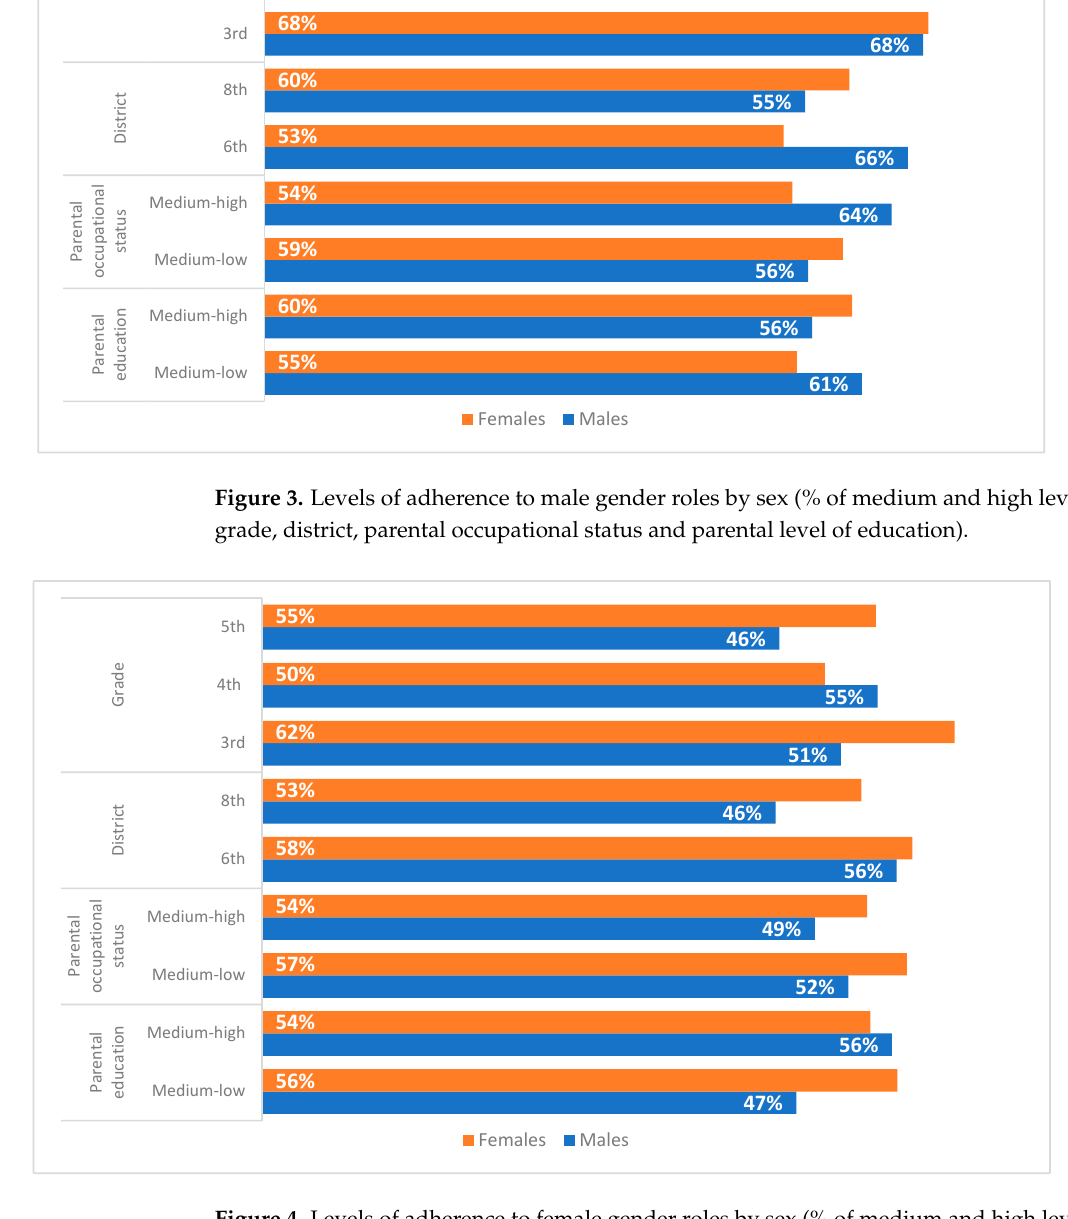
Figure 4. Levels of adherence to female gender roles by sex (% of medium and high levels by school grade, district, parental occupational status and parental level of